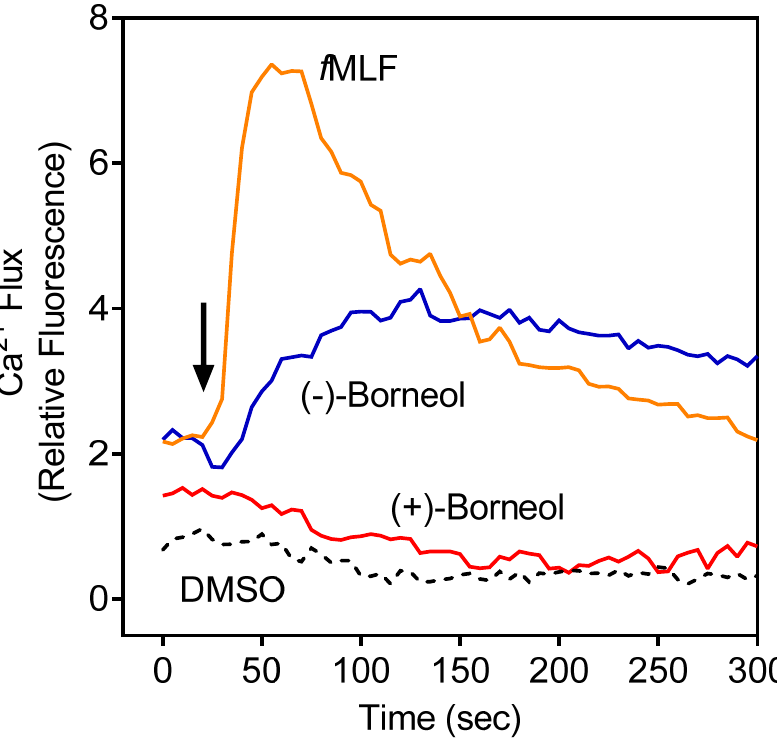
Figure 1. Direct effect of ( − )-borneol and (+)-borneol on neutrophil [Ca 2+ ] i . Human neutrophils were treated with 25 µ M ( − )-borneol, 25 µ M (+)-borneol, 5 nM f MLF (positive control), or 1% DMSO (negative control), and [Ca 2+ ] i was monitored for the indicated times (arrow indicates when treatment was added). Data are from one experiment that is representative of three independent experiments.